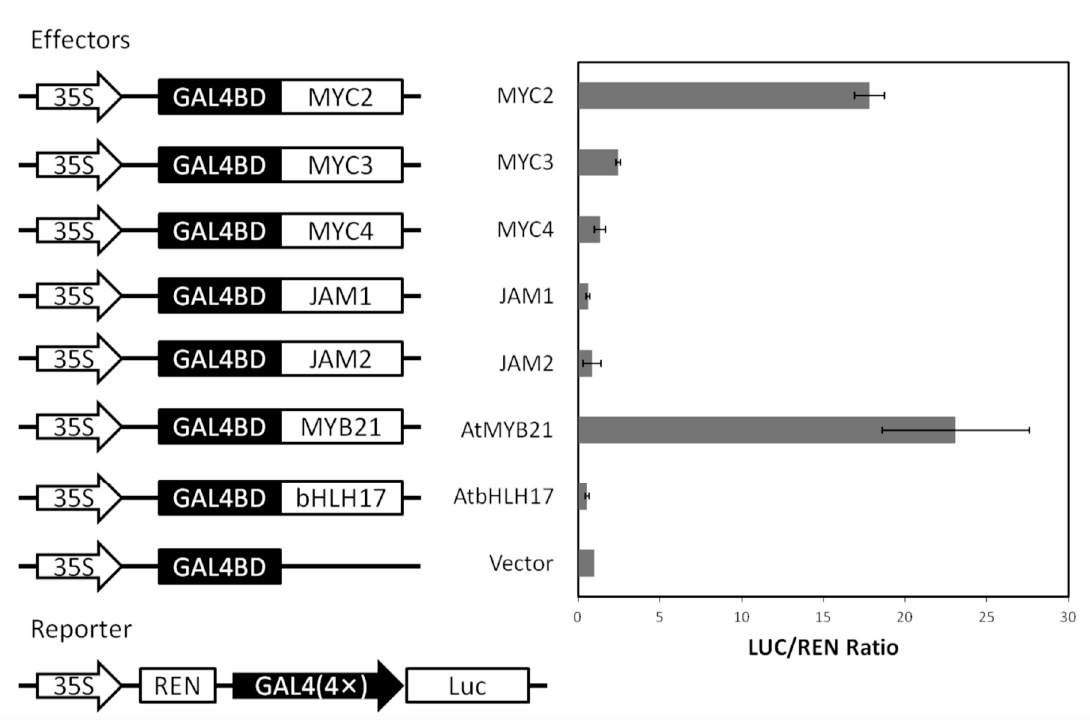
Figure A4. Detection of transcriptional activity of MYC-type transcription factors in protoplasts. The fusion protein overexpressing the MYC-type transcription factor and GAL4BD was used as the subtractor, the GAL4-regulated fluorescent protein LUC was used as the reporter gene, and the overexpressed red fluorescent protein REN was used as the internal reference to transfer into the Arabidopsis protoplasts to analyse the two kinds of fluorescence. The ratio between the signals. AtMYC21 and AtbHLH17 were used as positive and negative controls, respectively. Results are presented as a LUC/REN ratio. n = 3 in all samples, error bars are SE(* p = 1.02 x 10 -11 ).